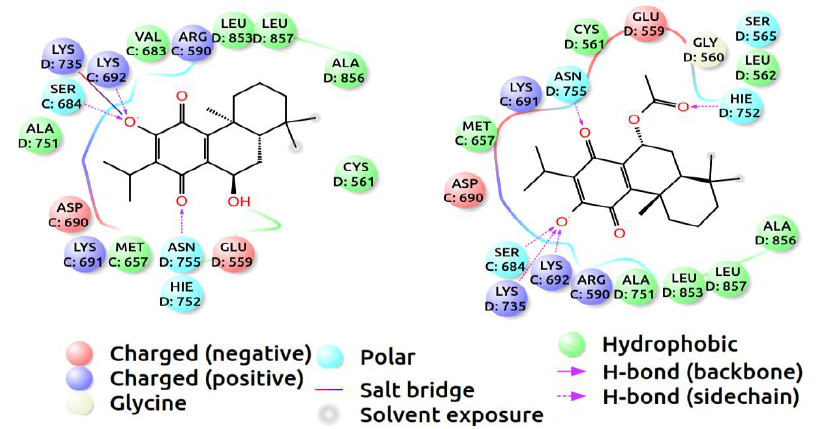
Figure 2. Two-dimensional ligand diagrams of horminone – 7-acetoxyhorminone ( left ) and 7-acetoxyhorminone ( right ). The chemical properties of the amino acids are represented by different colors.